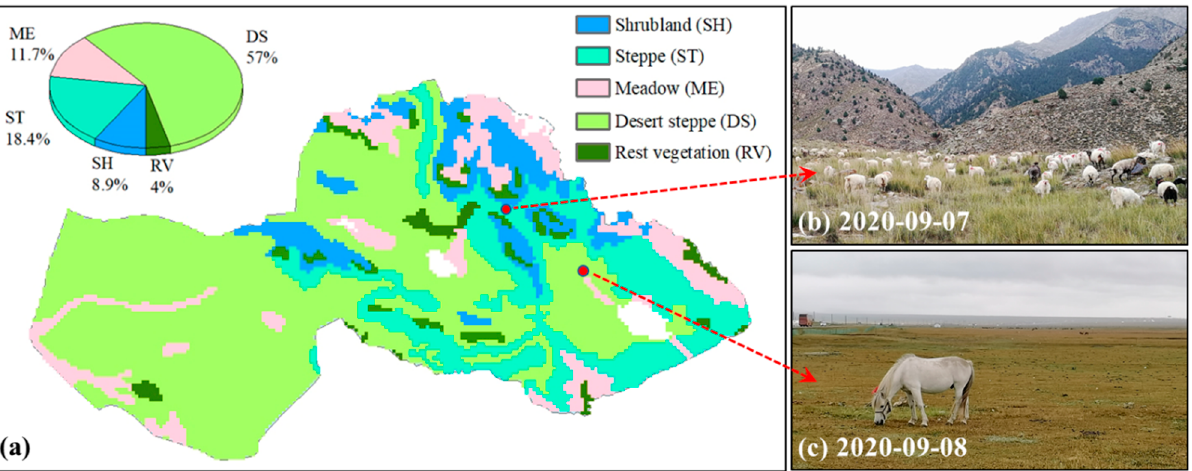
Figure 1. Geographic location of Wulan County and distribution of meteorological stations in study area.